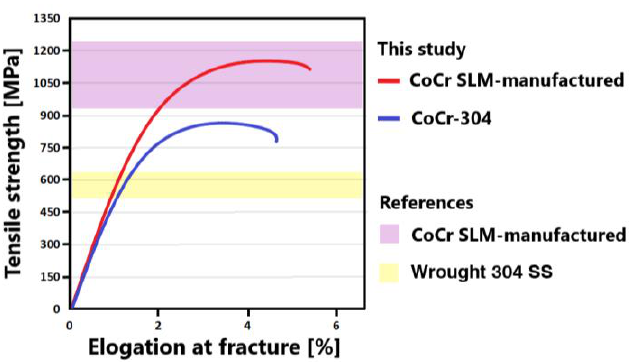
Figure 5. ( a ) SLM-fabricated specimens to test the adhesion between CoCr and the 304 substrate. The specimens after stress relief heat treatment: ( b ) CoCr – 304 specimens after mechanical testing.